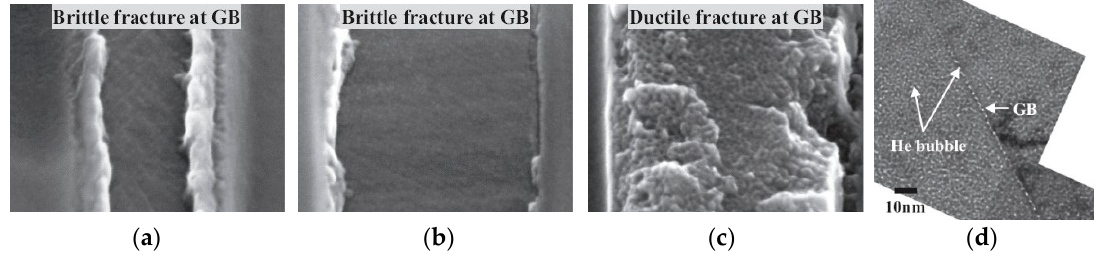
Figure 17. Unique SEM micrographs of grain boundary (GB) fracture of micro-tensile specimens of He-ion irradiated 15%CW316L, in a 45° perspective view: ( a ) 2% He; ( b ) 10% He; ( c ) 10% He post-irradiation annealed at 923K; ( d ) 6% He [18]. Reproduced with courtesy of K. Fukuya. Elsevier reuse license has been granted.